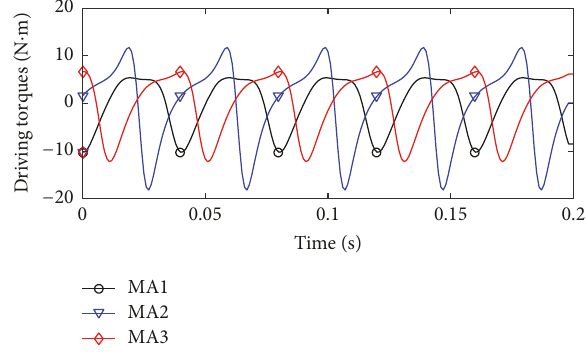
Figure 7: Three motor drive